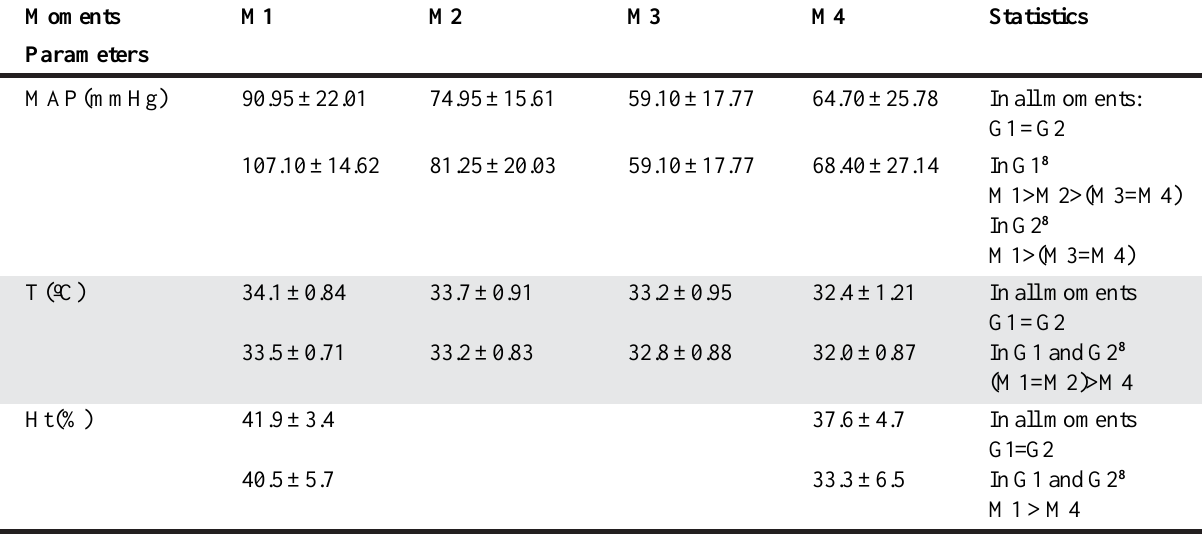
TABLE 1 - Medium arterial pressure (MAP), rectal temperature (T) and hematocrit (Ht). Values in Means ± S.E.M Moments